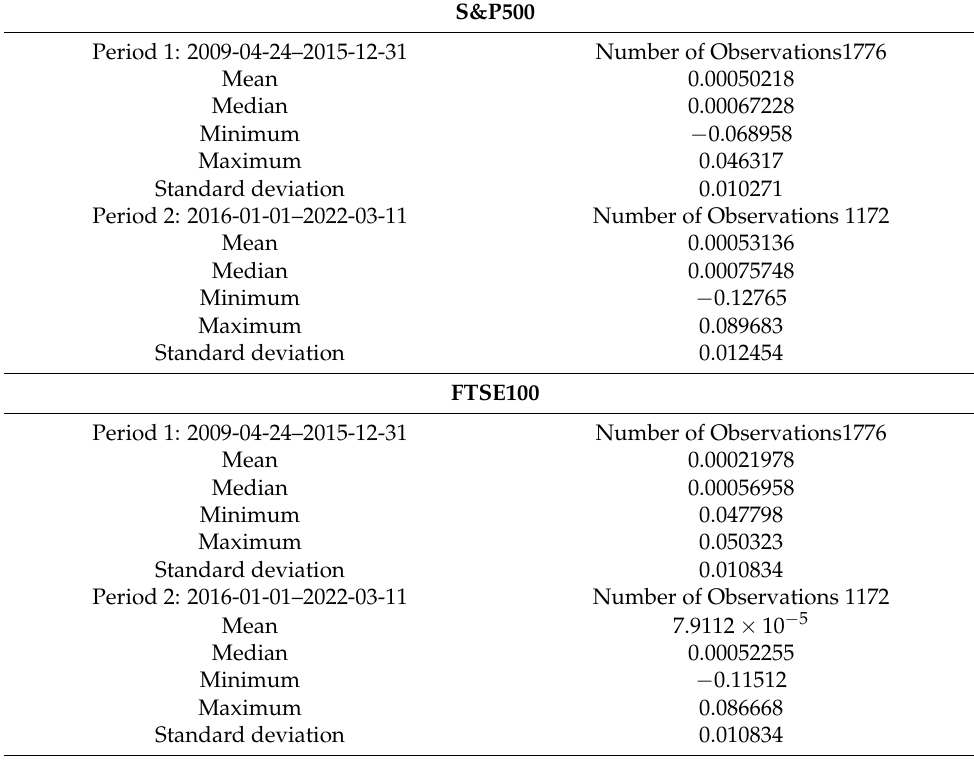
Table 1. Descriptive Statistics for the continuously compounded returns on the S&P500 and FTSE100 indices and analysis of variance